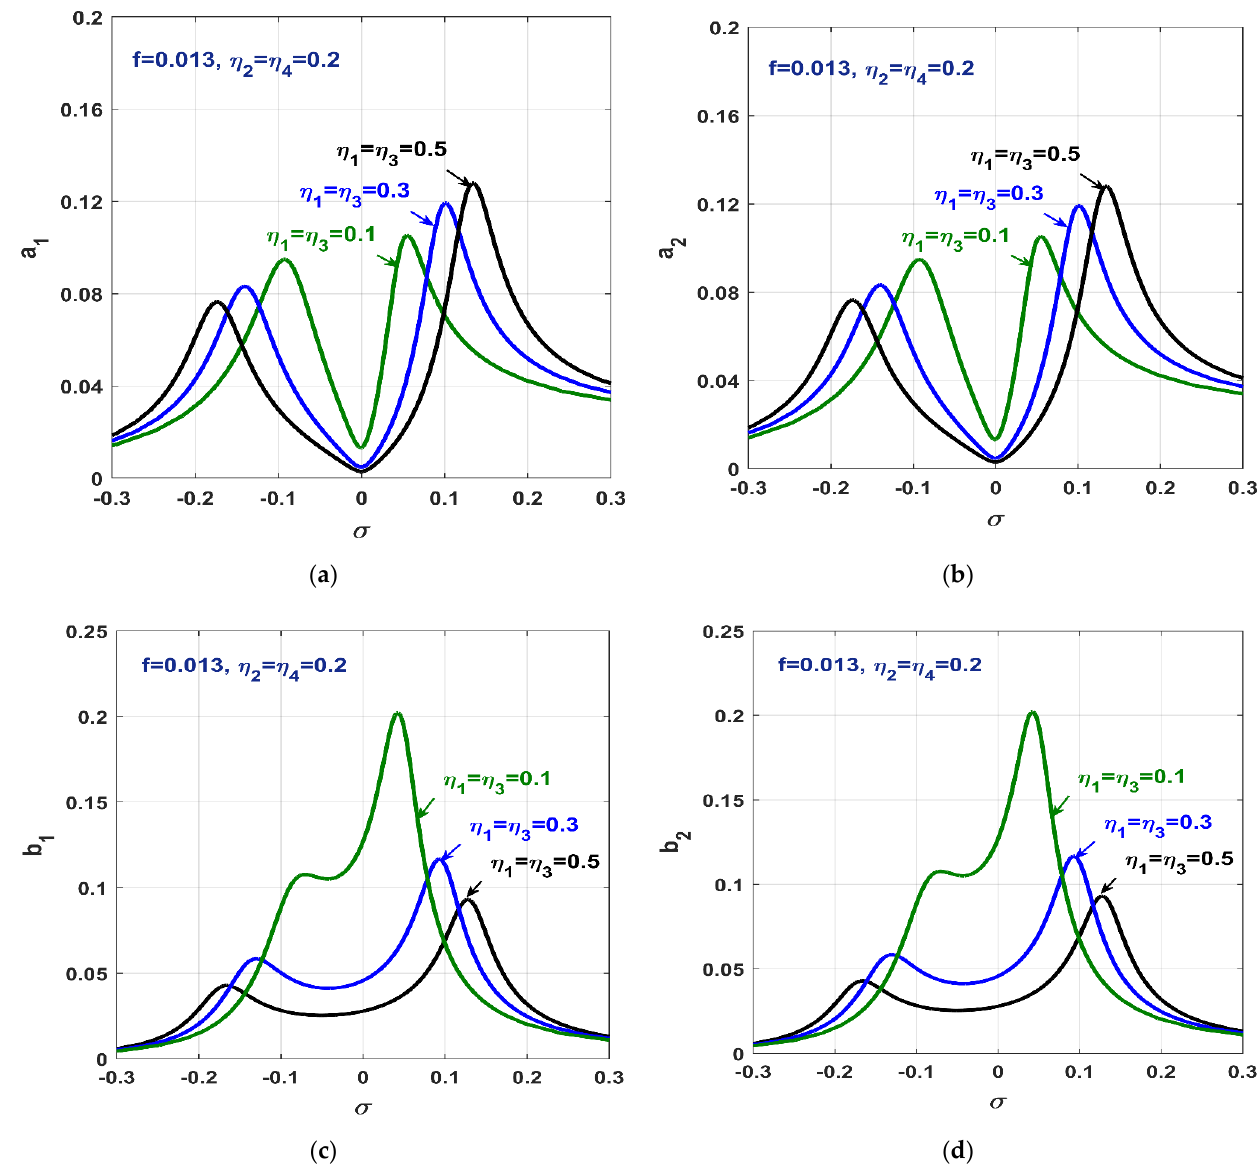
Figure 8. Vibration amplitudes of the twelve-poles rotor in the case of the PD + IRC + PPF -control algorithm at f = 0.013, P = 1.5, η 2 = η 4 = 0.2 when η 1 = η 3 = 0.1, 0.3, and 0.5: ( a , b ) vibration amplitudes ( a 1 , a 2 ) of the rotor, and ( c , d ) vibration amplitudes ( b 1 , b 2 ) of the PPF